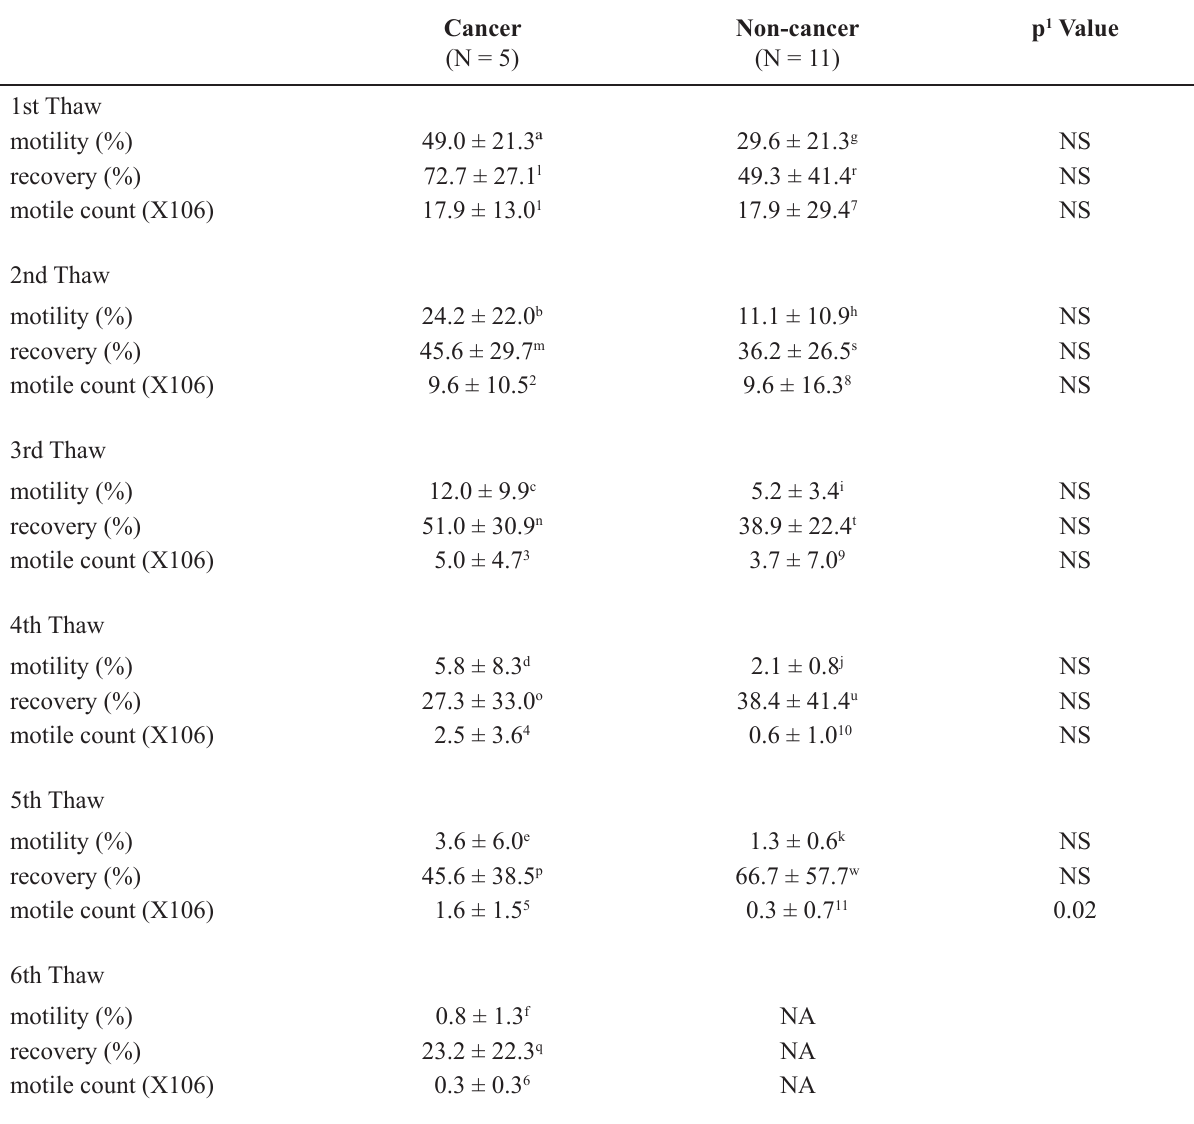
Table 4 – Percentage motility, percentage recovery of motile sperm between thaws and number of total motile sperm after each thaw in both cancer and non-cancer patients after repeated thaw-refreezing. Values are mean ±